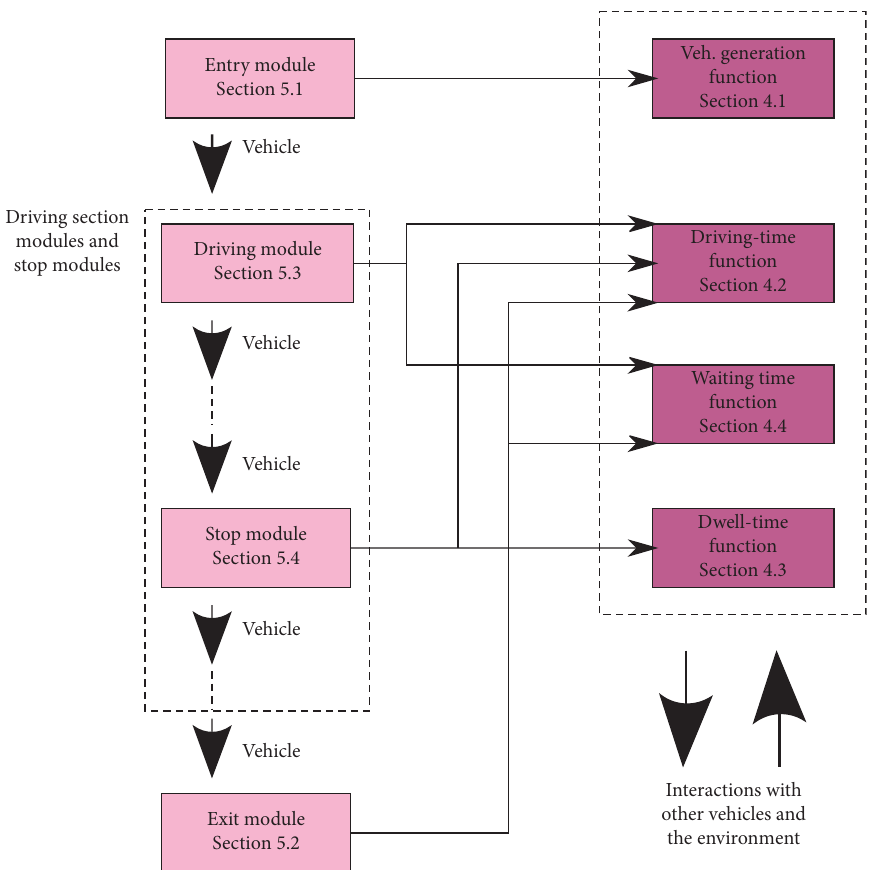
Figure 1: The path of one vehicle through the modules of the model. The vehicle is generated in one of the entry modules, pass through a series of driving and stop modules (this may include path choices where there are branching present) and leave the simulation at one of the exit modules. Each module uses a set of functions to determine the duration of activities. These functions include interactions with other vehicles and the